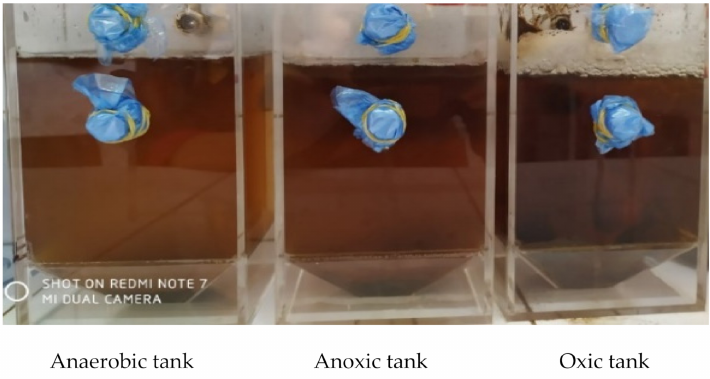
Figure 1. Activated sludge culture in the laboratory.